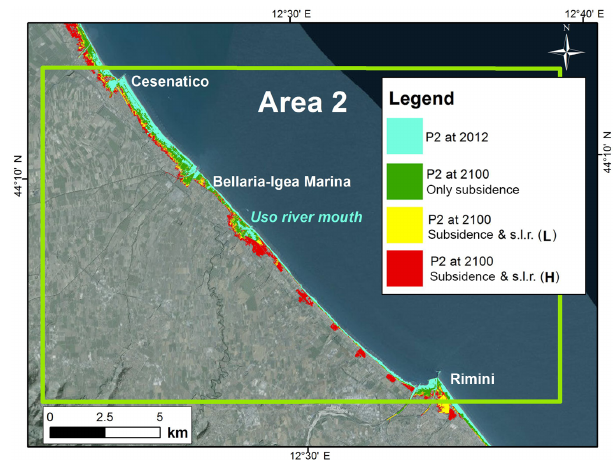
Figure 7. The same as in Fig. 6, but for Area 2.